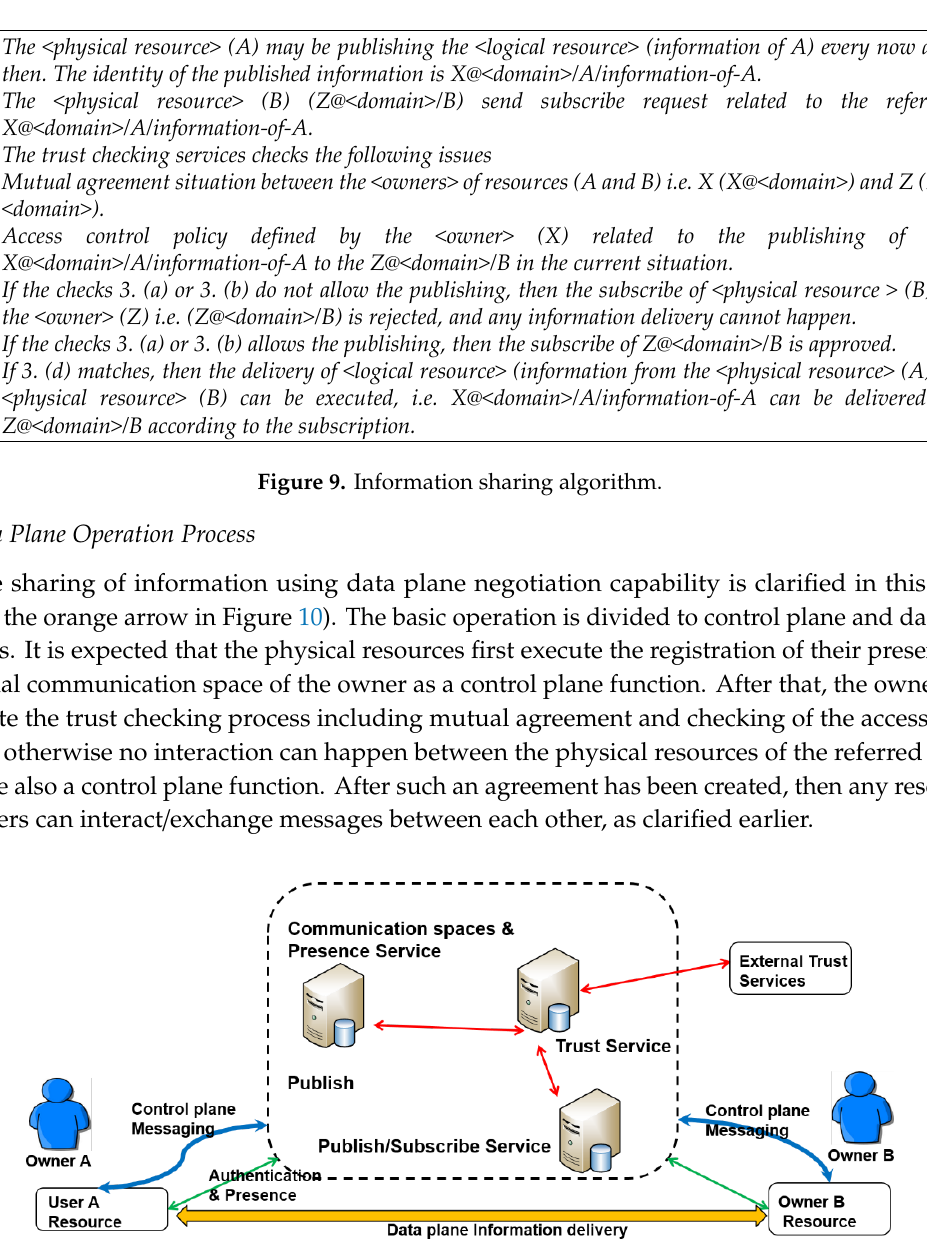
Figure 8. Information sharing process.